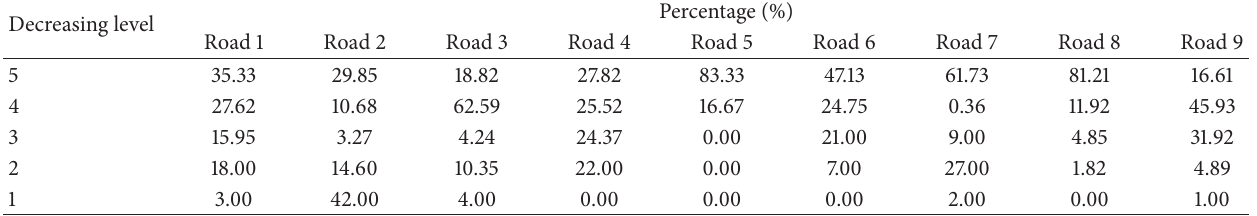
Table 11: Safety risk level summary results for all users with countermeasures performance.